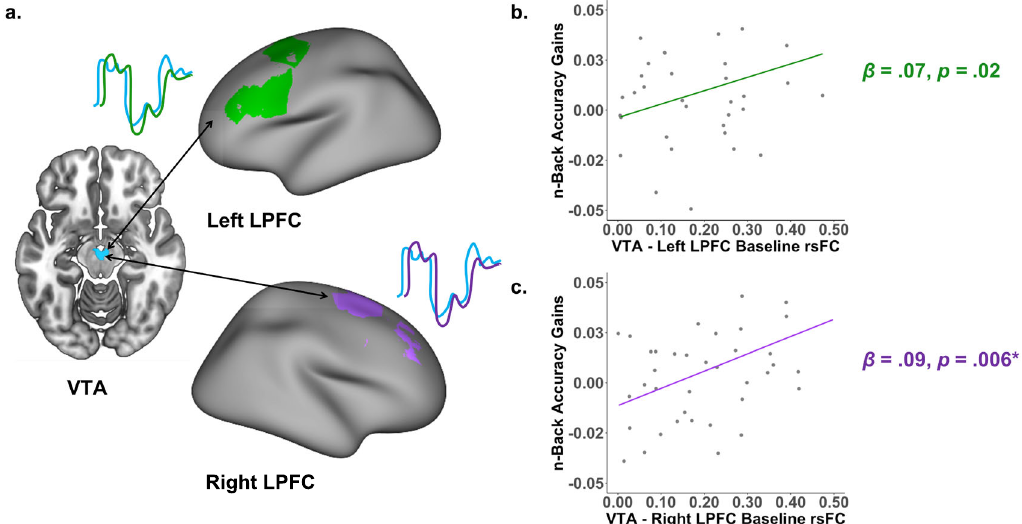
Fig. 3 Correlations between functional connectivity between the ventral tegmental area (VTA) and the lateral prefrontal cortex (LPFC) and improvements in accuracy. a Schematic of correlation between BOLD time series at rest of regions of interest. Colored lines represent the time series of positive functional connectivity between the VTA and the LPFC at rest. b Positive relationships between baseline VTA-left LPFC resting- state functional connectivity (rs-FC) and accuracy gains on the n -back working memory task. c Positive relationships between baseline VTA-right LPFC rs-FC and accuracy gains on the n -back working memory task. Relationships between connectivity and accuracy gains did not survive FDR correction over 28 tests (7 ROIs [5 task-based, 2 control], 2 learning measures [accuracy, response time], and 2 neural measures [VTA rsFC, T1w/T2w ratio]). Statistical models control for age, sex, motion, and baseline working memory accuracy. Asterisks denote p -values that survive